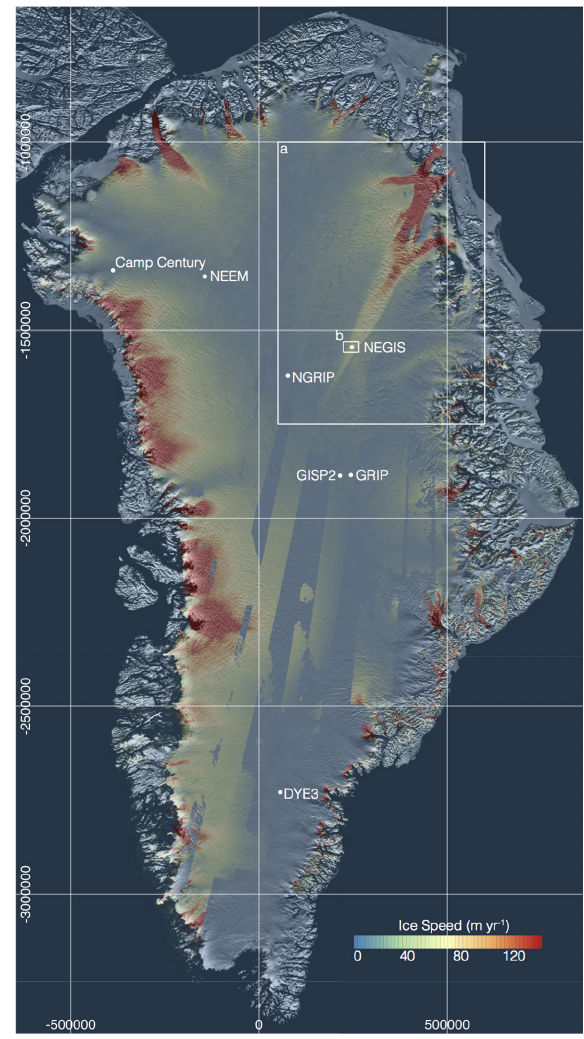
Figure 1. Locations of Greenland ice core drilling sites NEGIS, NEEM, NorthGRIP (NGRIP), GRIP, GISP2, DYE3, and Camp Century. The white boxes a and b denote the areas shown in Figs. 2 and 4, respectively. Velocities from interferometric synthetic aper- ture radar data are shown in colour (Joughin et al., 2010). Back- ground is MODIS imagery (T. Haran, personal communication,